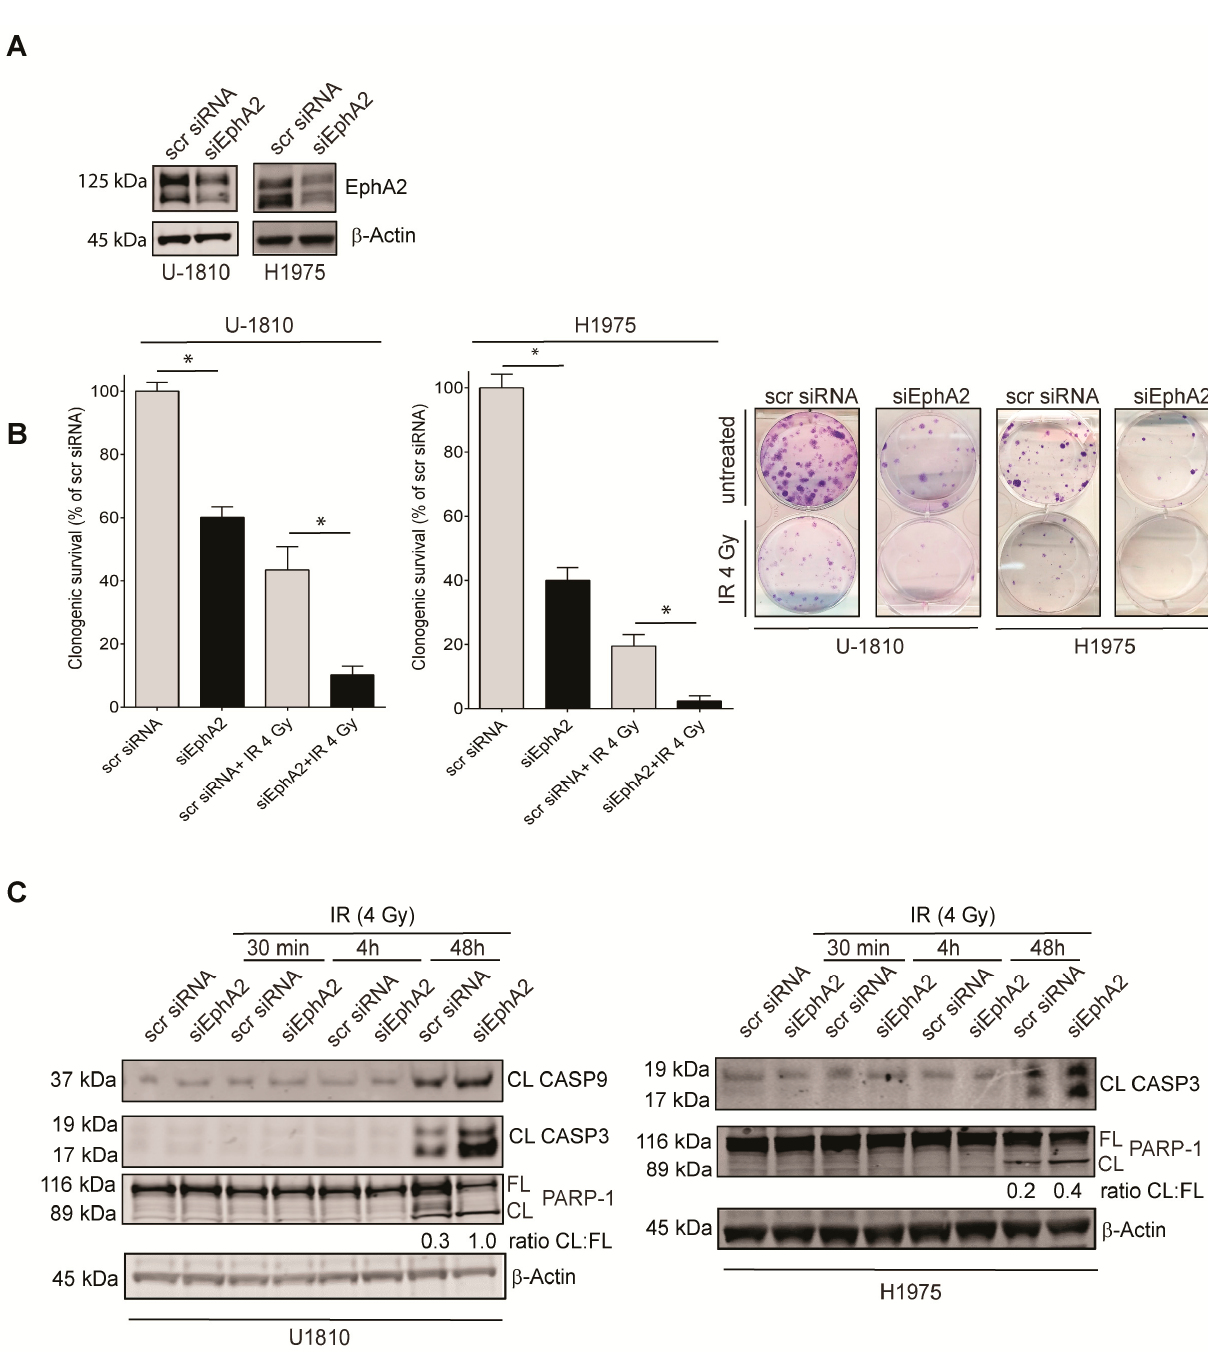
Figure 2. Silencing of EphA2 in non-small cell lung cancer (NSCLC) potentiates ionizing radiation (IR)-induced apoptotic cell death and reduces clonogenic survival. ( A ) EphA2 expression was silenced in U-1810 and H1975 cells using siRNA. β -Actin was used as a loading control. ( B ) U-1810 or H1975 cells were transfected with either scrambled (scr) siRNA or EphA2 siRNAs (siEphA2) for 24 h, irradiated (4 Gy) and thereafter seeded in 6-well plates for colony formation assay. The results are presented as percentages of colony survival in relation to non-irradiated scr siRNA transfected cells. Mean and SD bars are presented from one transfection of cells that were trypsinized, counted and seeded for colony formation in three independent dishes. Statistical significance was cal- culated by t -test, and p < 0.05 is indicated by *. Pictures of cell colonies transfected with indicated siRNAs with or without irradiation (4 Gy) are shown. ( C ) Cleavage of PARP-1, processing of caspase-3 and caspase-9 in samples from ( A ), which were irradiated (4 Gy) at 24 h post silencing. The cells were collected at 30 min, 4 h or 48 h post IR and analyzed for full length and cleaved PARP-1, cleaved caspase-3 and cleaved caspase-9 with β -Actin used as a loading control. Densitometry analysis was performed and the ratios of cleaved fragment of PARP-1 (CL) to its full length (FL) form are shown.